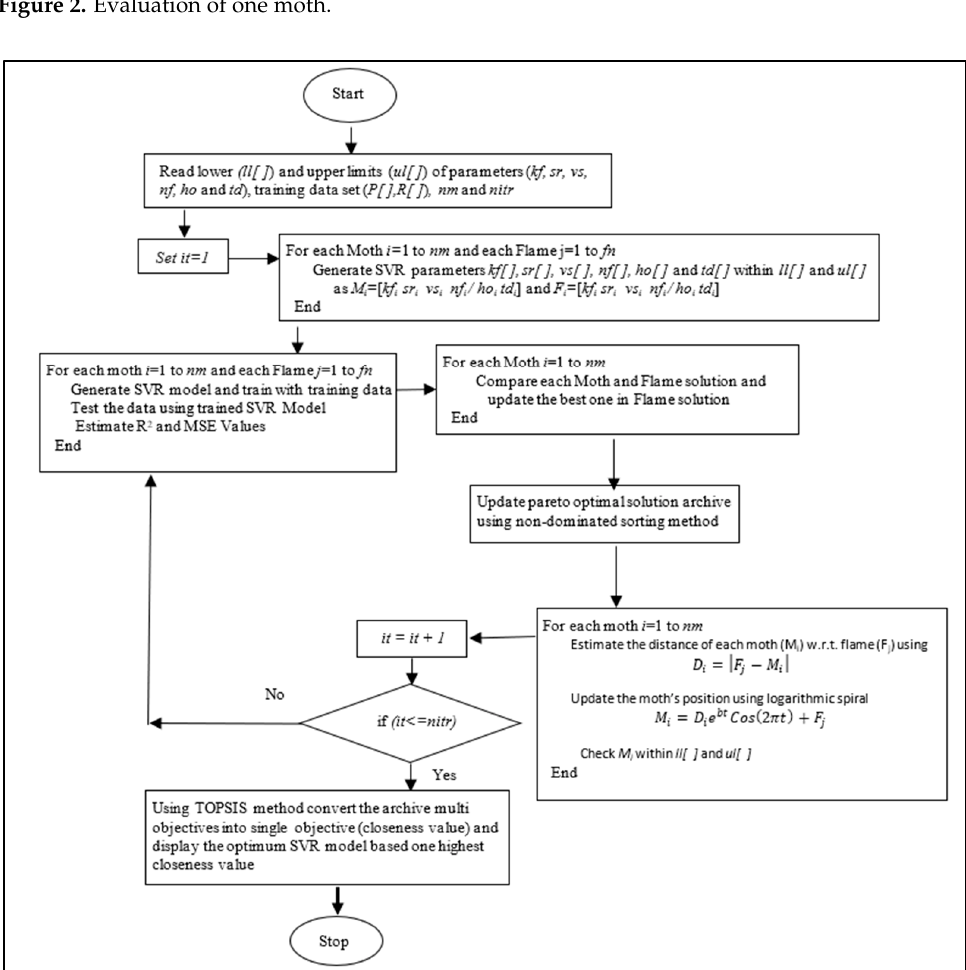
Figure 3. Implementation of MFO Algorithm.